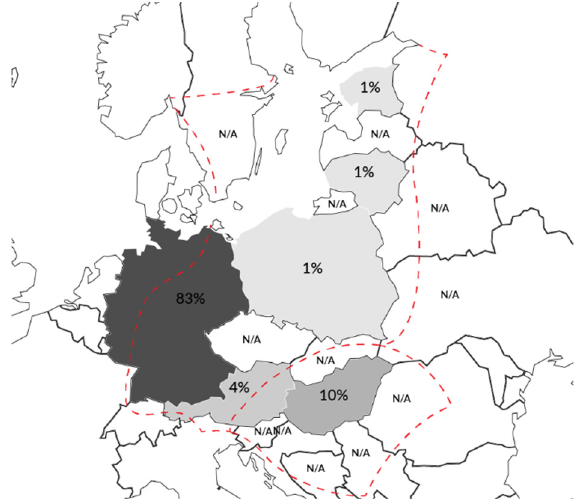
Figure 4. Geographic analysis of passive buildings.